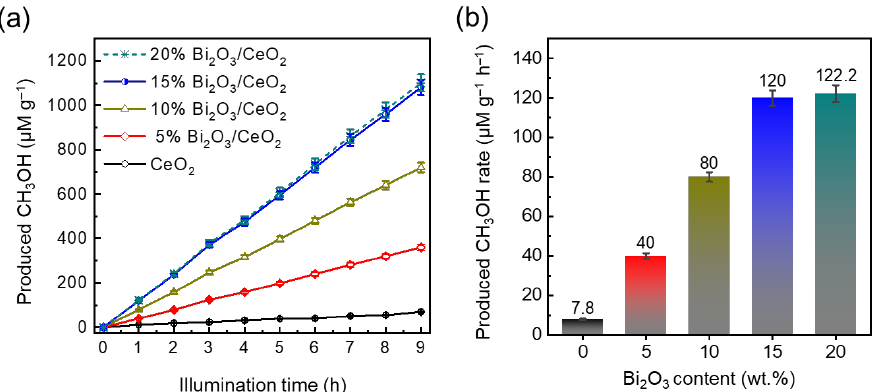
Figure 6. Photocatalytic production of CH 3 OH utilizing the produced CeO 2 and Bi 2 O 3 /CeO 2 heterojunctions as in ( a ). The influence of adding Bi 2 O 3 on the generation rate of produced CH 3 OH is illustrated in ( b ).